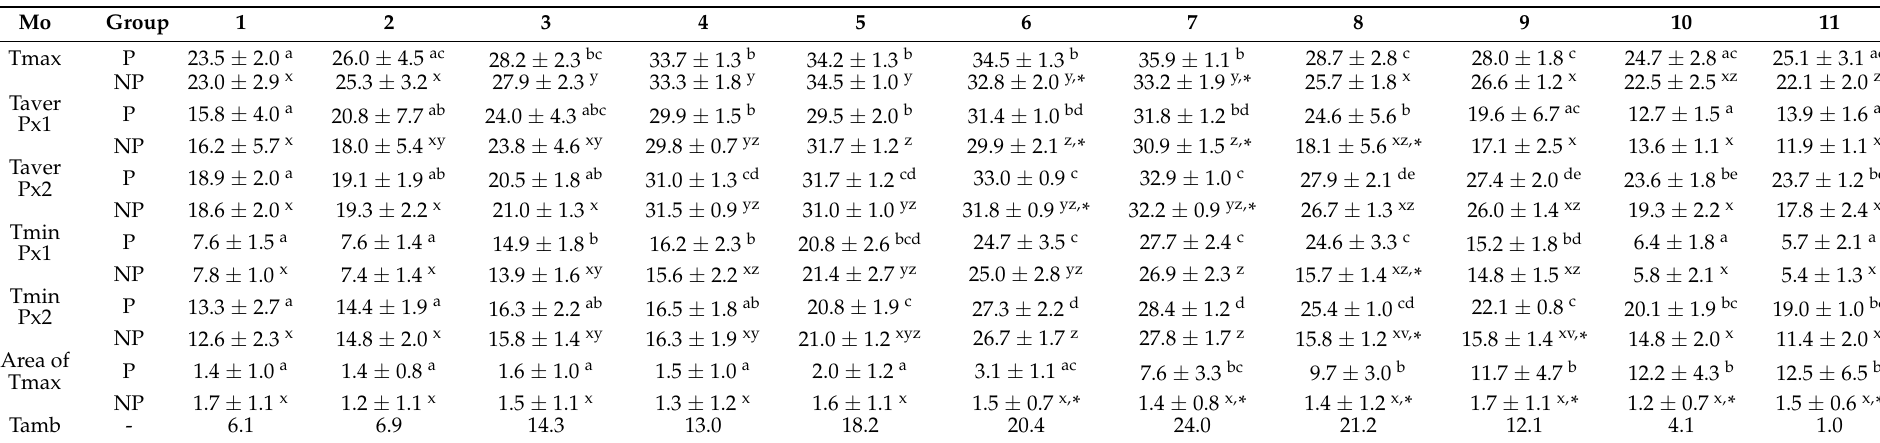
Table 1. Values of selected thermal features: maximal temperature ( ◦ C), average temperature ( ◦ C), minimal temperature ( ◦ C), and area with the highest temperatures in the range of 3 ◦ C (%) of the lateral surface of abdomen of pregnant (P; n = 26) and non-pregnant (NP; n = 14) mares in consecutive months of pregnancy. Mo